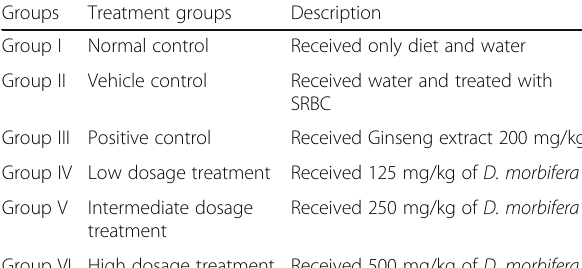
Table 1 Group arrangement and experimental design of